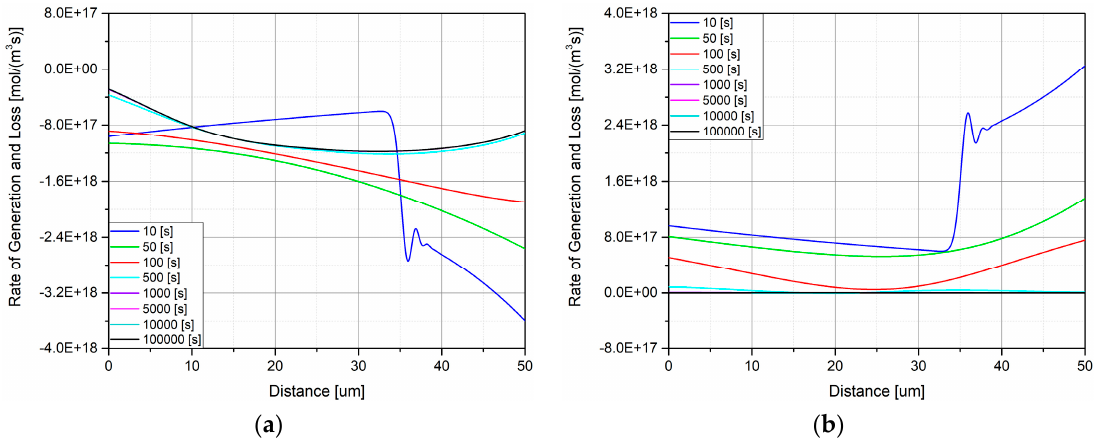
Figure 5. Rates of generation and loss of carriers at 60 °C: ( a ) mobile carriers; ( b ) trapped carriers. Figures 6–8 represent the mobile and trapped charge density, and total charge density at di ff erent temperature conditions. Left and right sides of the horizontal axis represent the cathode and the anode, respectively. The vertical axis denotes time, which is expressed as a log scale. Positive and negative color legends represent charge density of holes and electrons, respectively. Note that the ranges of scales represented by color legends are di ff